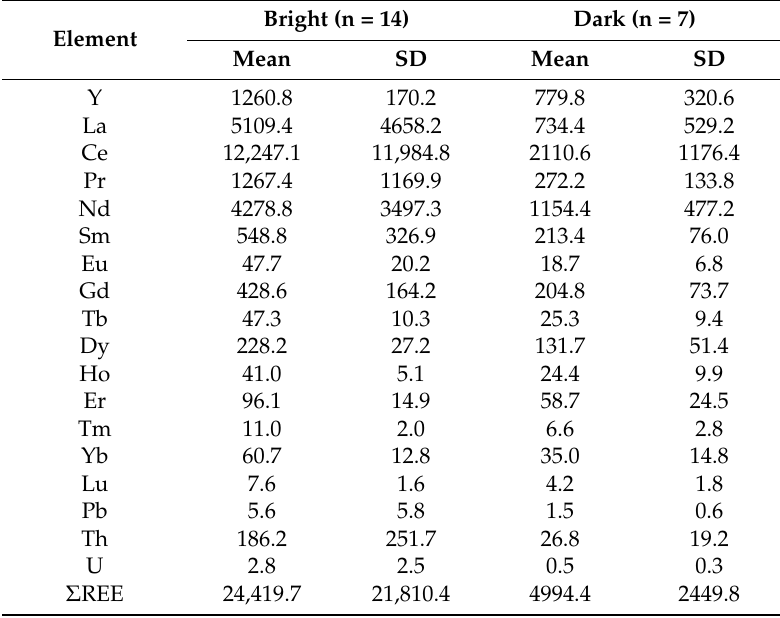
Table 6. LA-ICP-MS data (ppm) for bright and dark apatites from Chadormalu MAA-marginal ore apatite type.